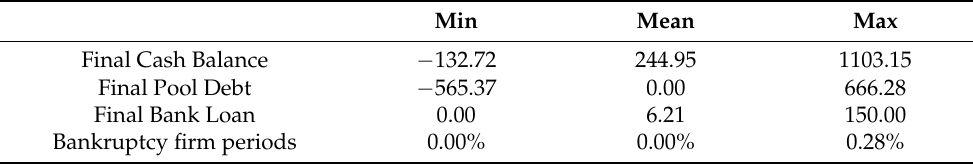
Table 14. Results for diverse operational risk and loan limits with cooperation.